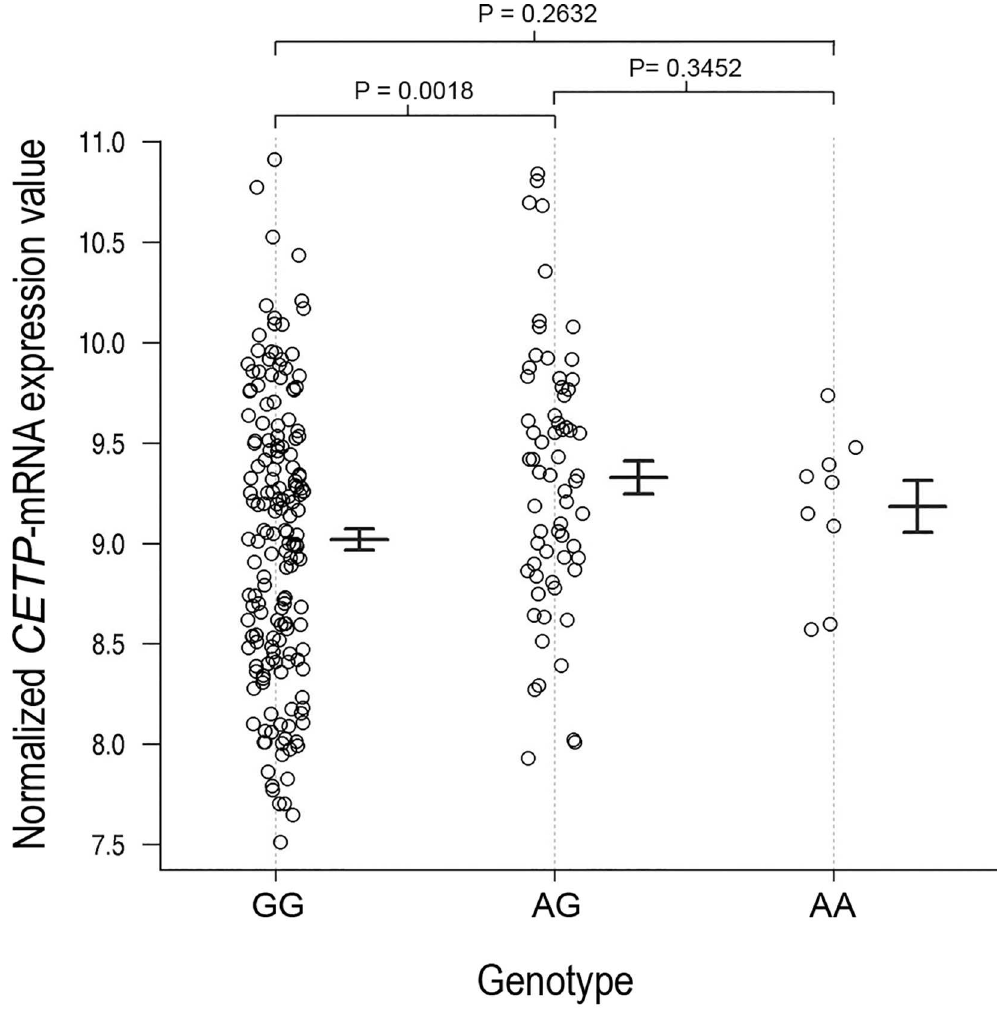
Fig 2. Expression data of CETP in HapMap population according to their genotype. Middlebar represents the mean value of expression while flanking bar represents their standard